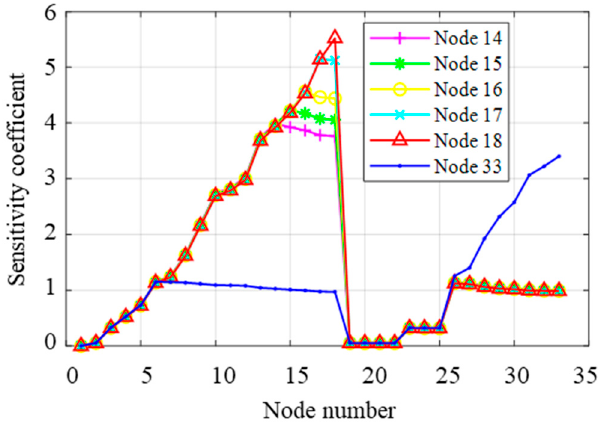
Figure 16. Sensitivity coefficients of nodes 14, 15, 16, 17, 18, and 33. Table 4. Sensitivity coefficients of node 17 and 18.